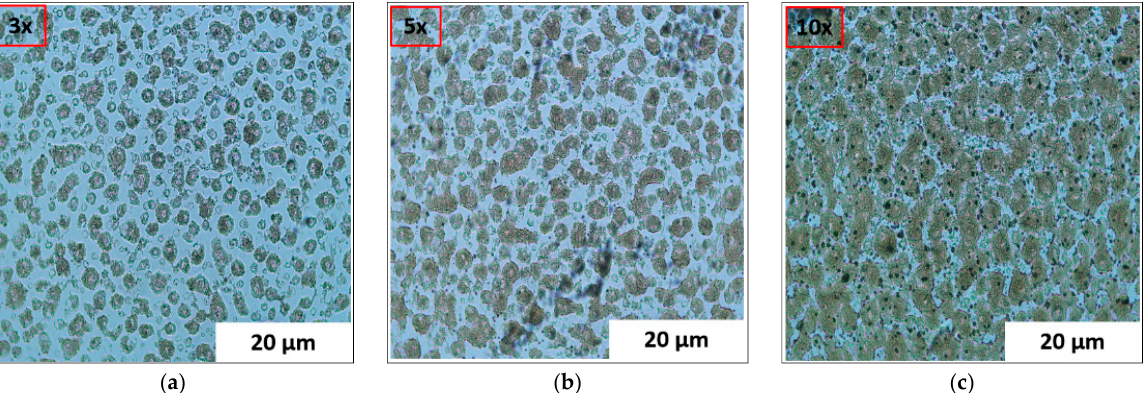
Figure 2. ( a ) Optical microscopic (OM) image of 3× ZnO nanoparticle (NP)-coated polyethylene terephthalate (PET) substrate; ( b ) OM image of 5× ZnO NP-coated PET substrate; ( c ) OM image of 10× ZnO NP-coated PET substrate.